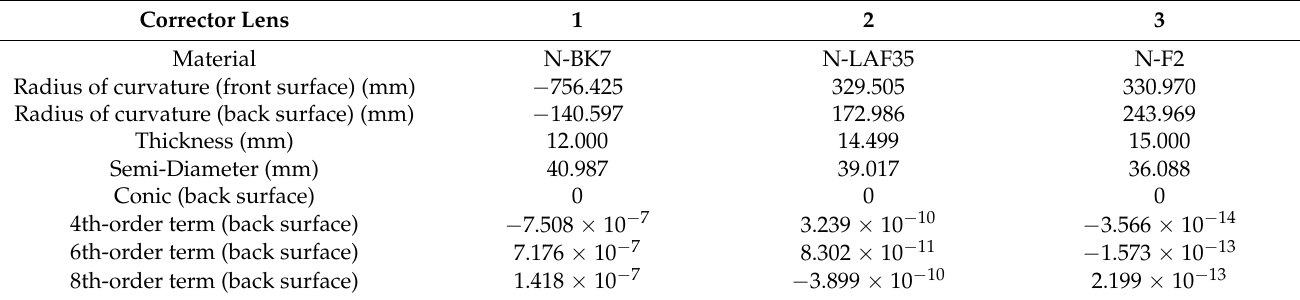
Table 3. The parameters of the three-element corrector group.